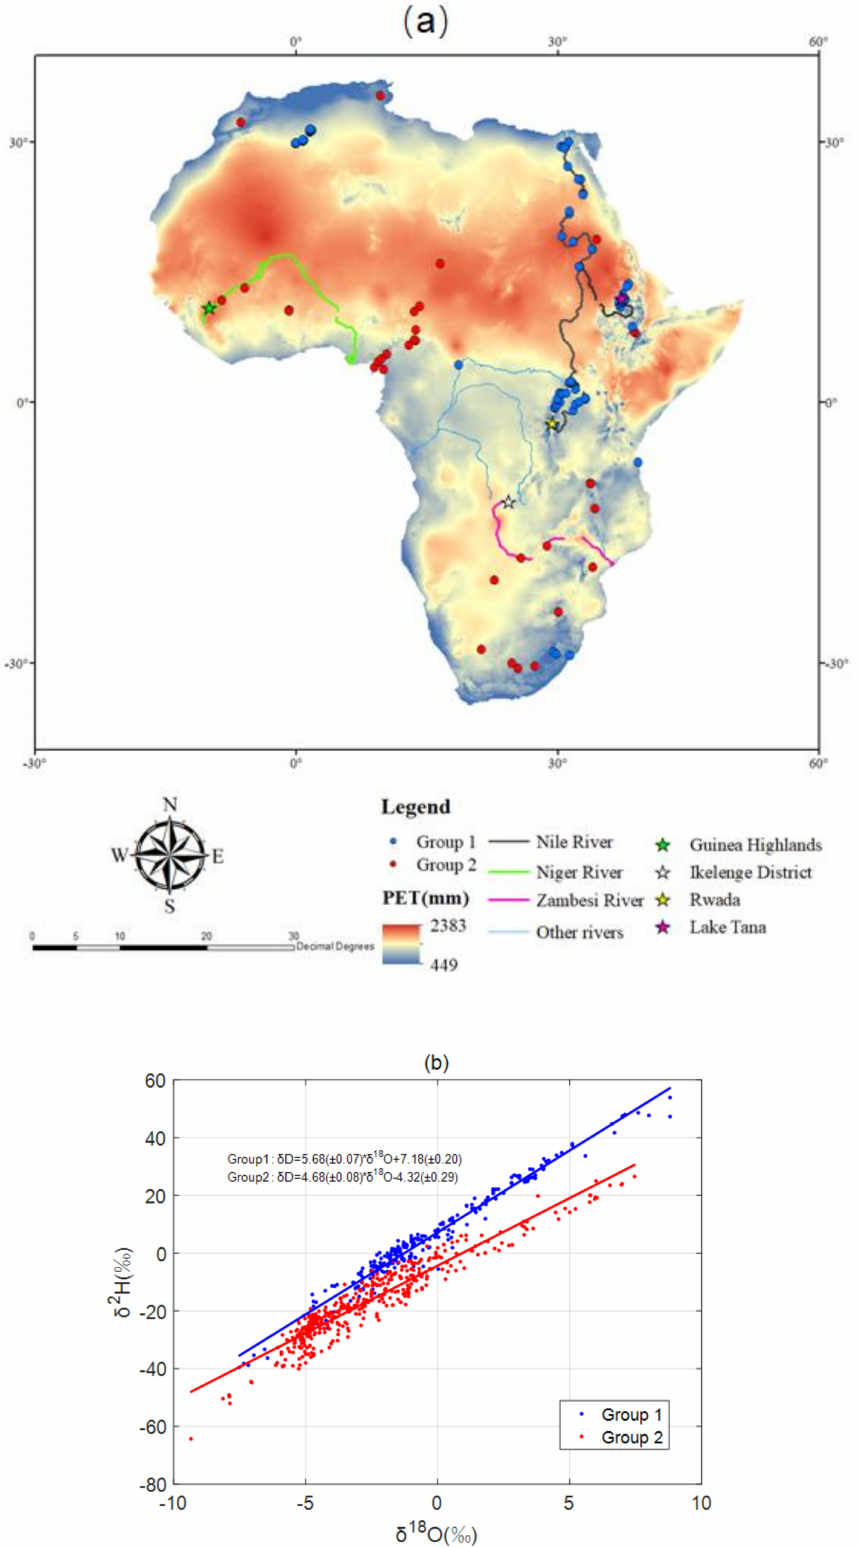
Figure 11. Group of isotopic data in Africa. ( a ) Location of data points in Africa. ( b ) 2 H- δ 18 O relationship in Africa. Blue and red points stand for data points with high and low slopes, respectively. Background of ( a ) is the annual potential evapotranspiration (PET) data from CGIAR-CSI [41,42]. Lines in the map are the major rivers in Africa according to Naturalearthdata [58]. Stars in the map represent the source regions of Niger, Nile and